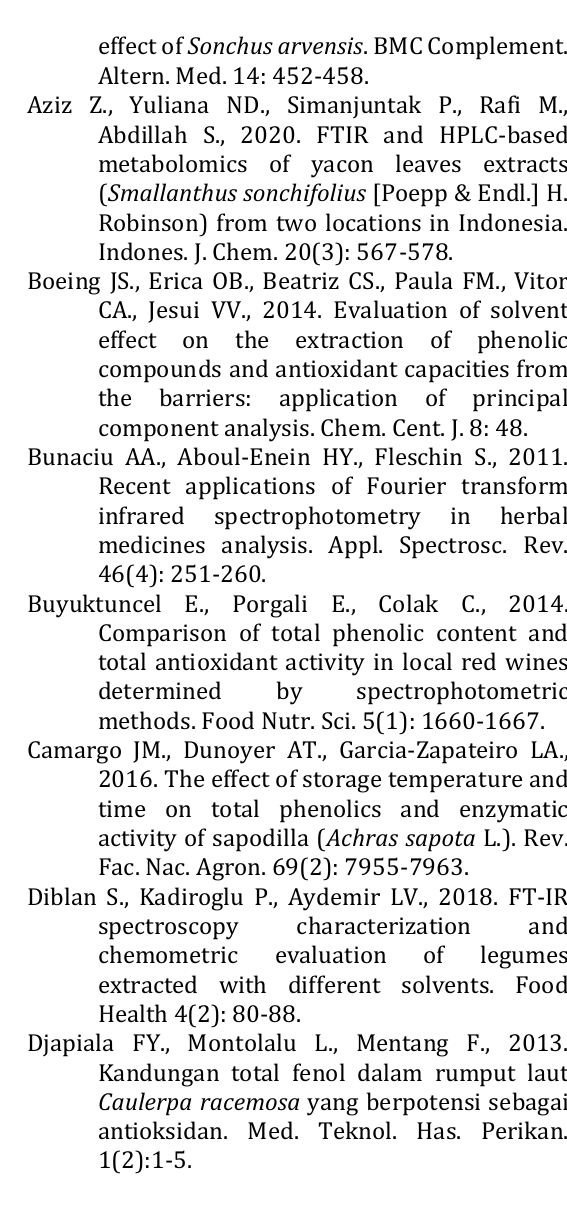
Figure 3. Regression coefficient plot of S. arvensis leaves